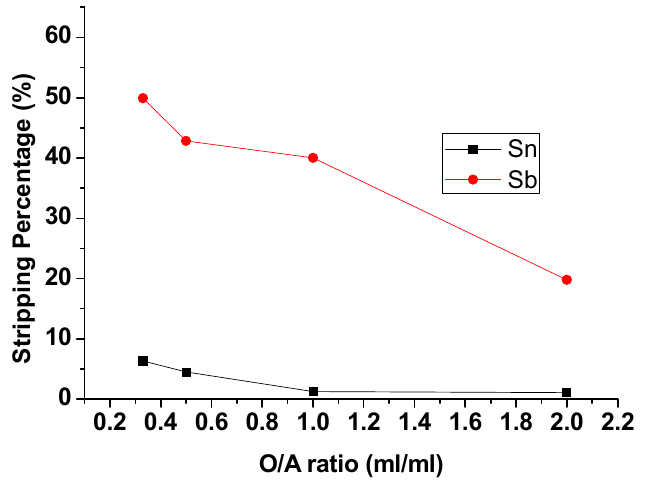
Figure 6. Stripping percentage of Sn and Sb at different concentrations of HCl. O/A ratio = 1, reac- tion time = 5 min.